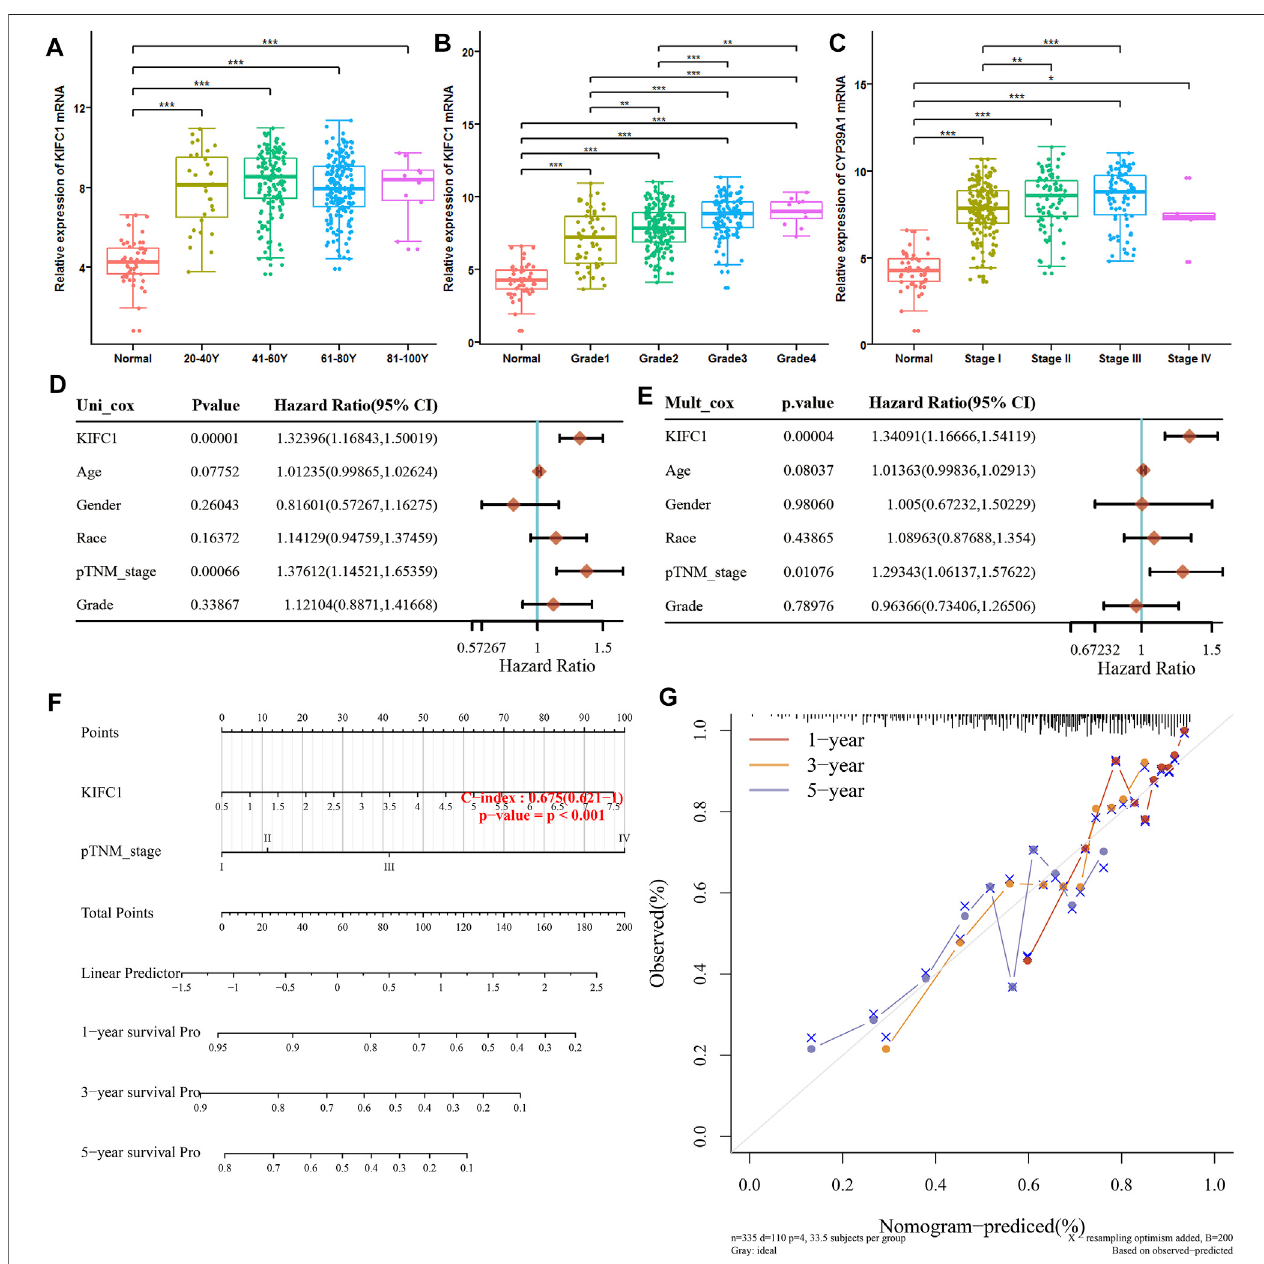
FIGURE 3 | Univariate and multivariate analysis of prognostic factors of LIHC. (A) Relative expression of KIFC1 in subgroups of patients with LIHC based on age. (B) Relative expression of KIFC1 in subgroups of patients with LIHC based on grade. (C) Expression of KIFC1 in subgroups of LIHC patients based on stage. (D, E) Hazard ratio and p -value of constituents involved in univariate and multivariate Cox regression of the KIFC1 gene and other clinical characteristics. (F) Nomogram predicting the 1-year, 3-years and 5-year OS of LIHC patients. (G) The calibration plots for predicting patient 1-year, 3-year, and 5-year OS. * p < 0.05, ** p < 0.01, *** p <